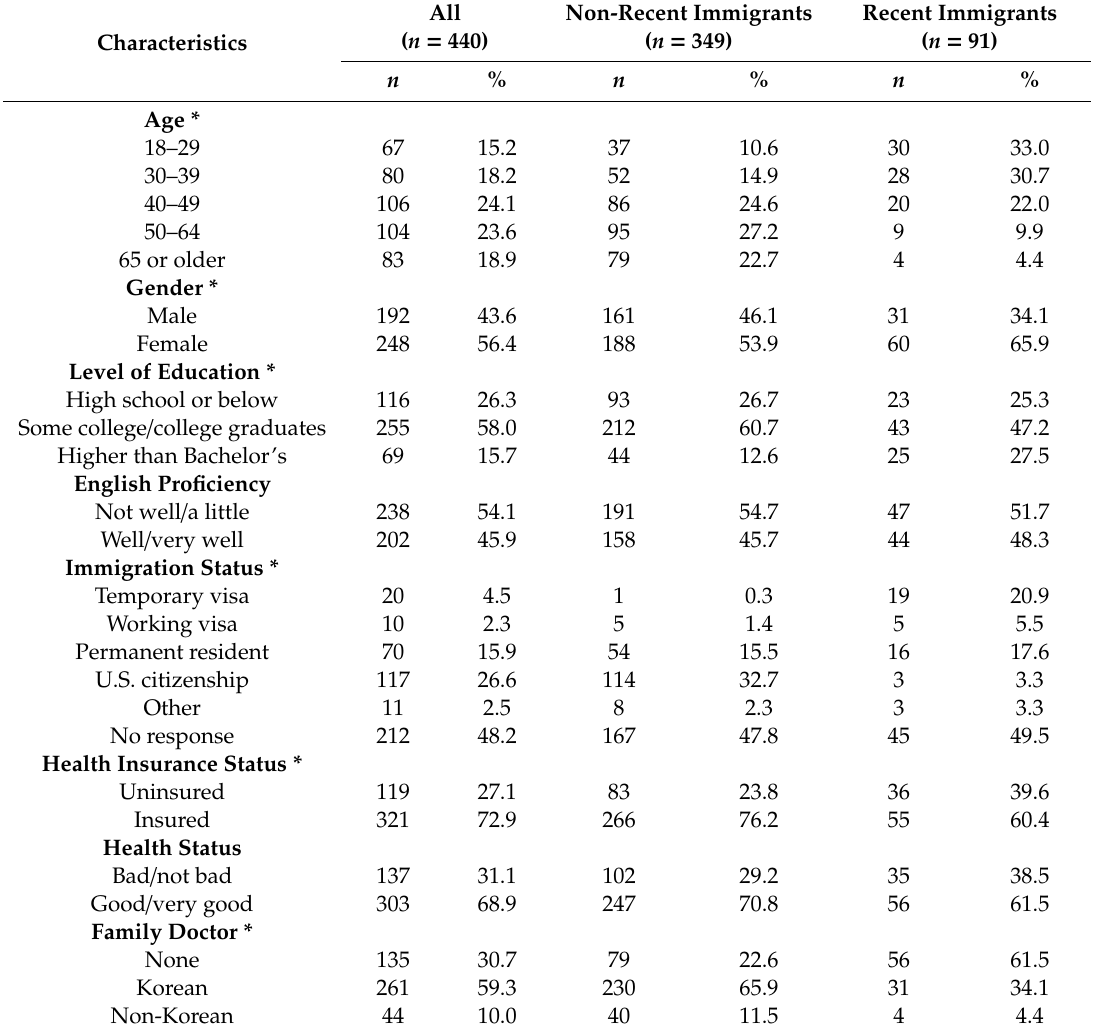
Table 1. Characteristics of Korean immigrant survey participants.